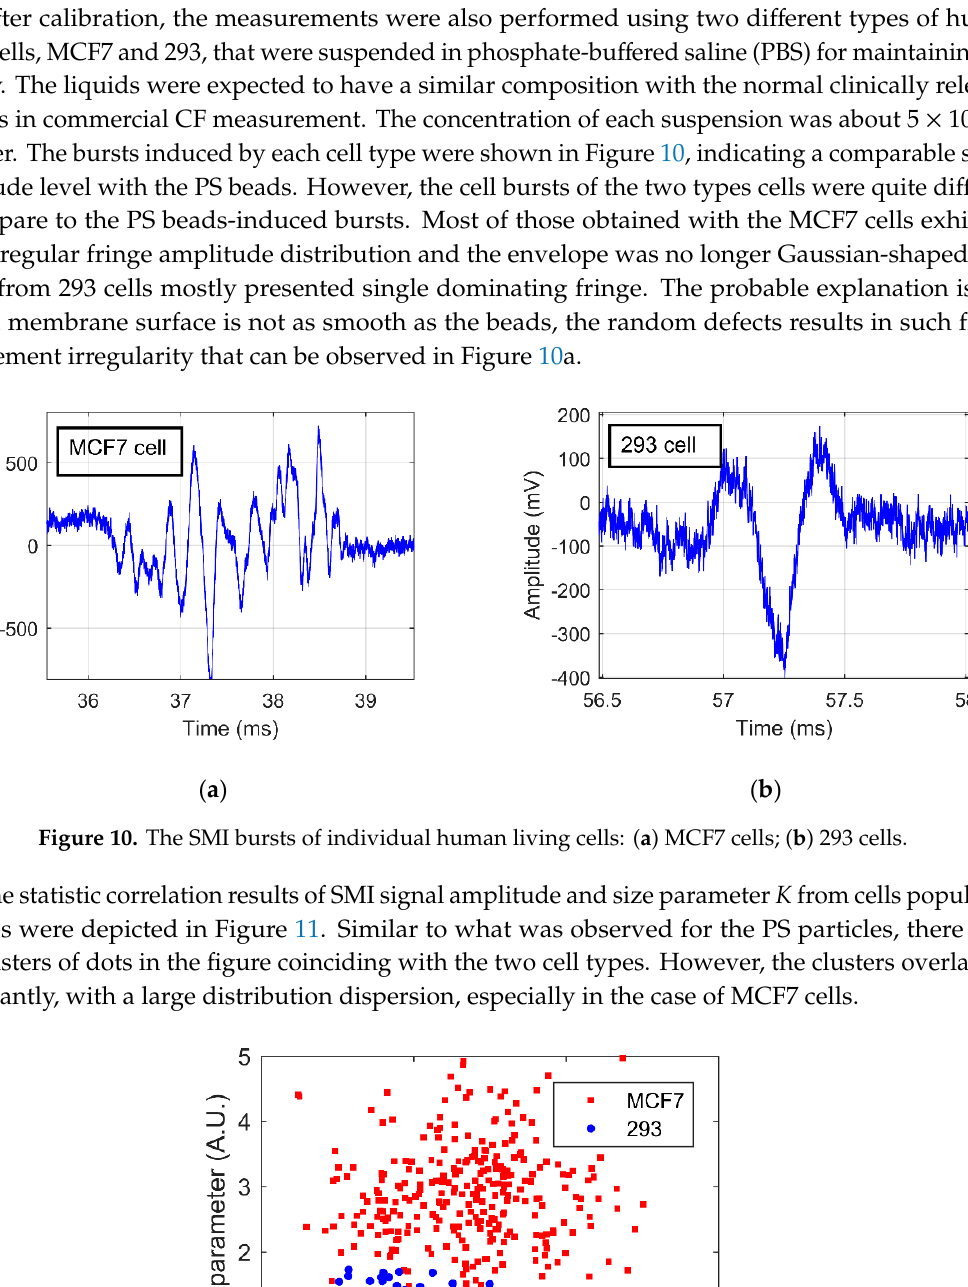
Figure 9. The profiles of the measurement results as a function of PS particle diameter. ( a ) Size particle K . ( b ) SMI signal amplitude.